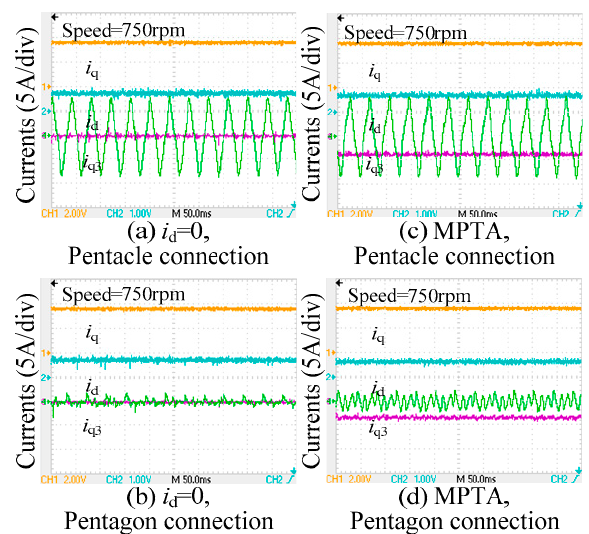
Figure 11. Waveforms of d-q-q3 frame currents and rotor speed under a single open-phase fault.